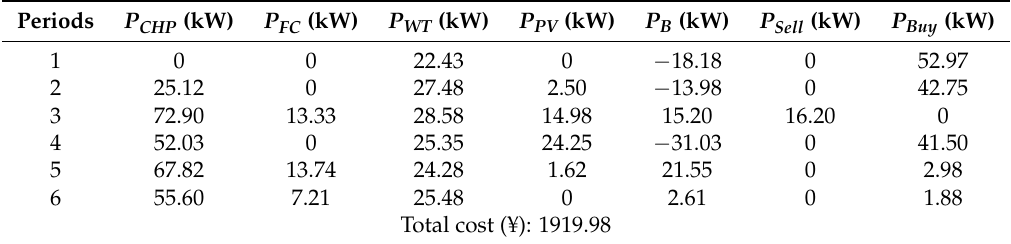
Table 4. Output power of different generators in a traditional distributed network, which does not have any portable energy system installed.